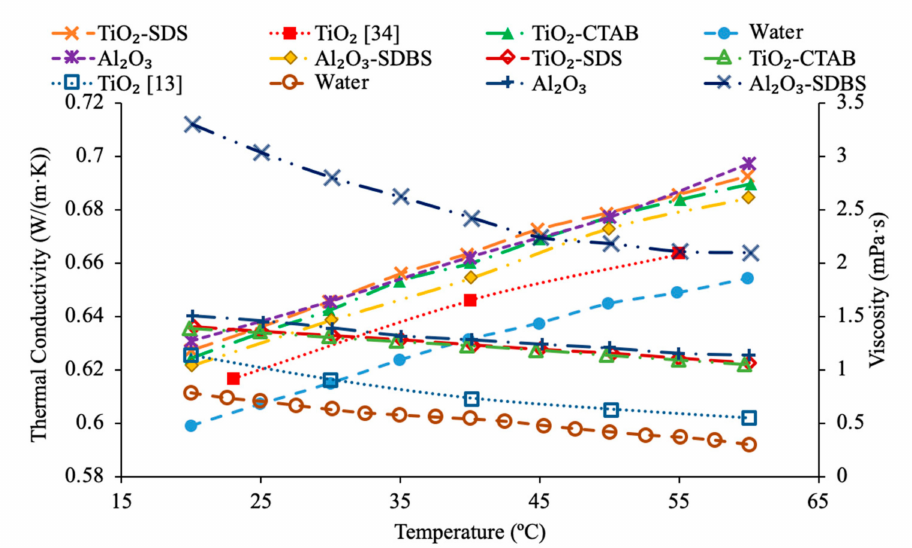
Figure 13. Thermal conductivity (increasing with temperature) and viscosity (decreasing with temperature) of TiO 2 –water nanofluids at 1% volume fraction with 0.39% SDS and 0.39% cetyl trimethyl ammonium bromide (CTAB) surfactants [44], TiO 2 with no surfactant [13,34], and Al 2 O 3 – water nanofluids at 1% volume fraction with and without SDBS surfactant [46].